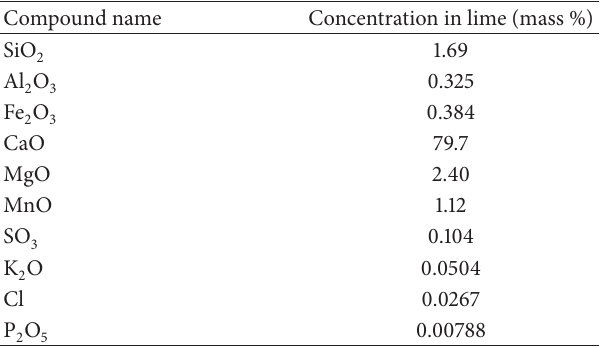
Table 5: Chemical composition of lime as determined by XRF.